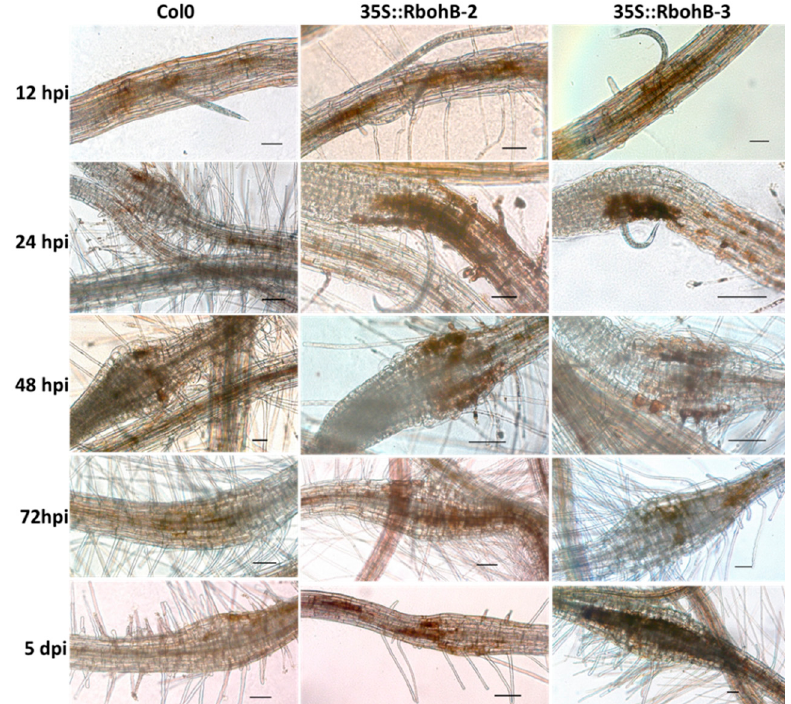
Figure 6. Reactive oxygen species (ROS) production. DAB (3, 3-diaminobenzidine) staining of infection sites of M. incognita in wild type and overexpression lines of RbohB at different time points after inoculation. Scale bar = 100 μ m.